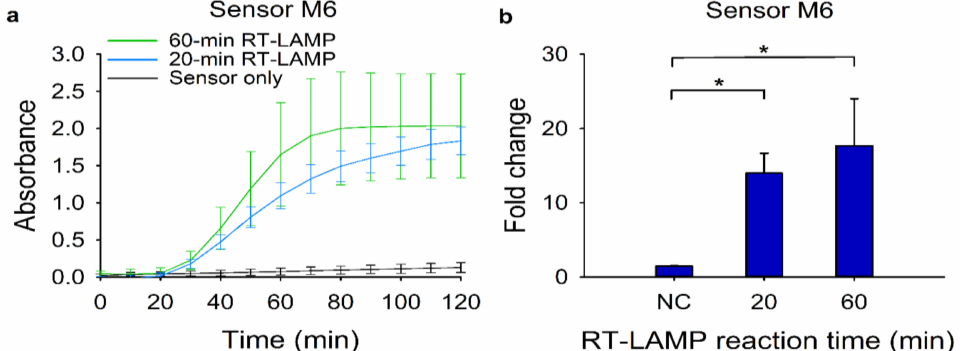
Figure 5. Reduction of the overall reaction time for the modified RT-LAMP and the subsequent toehold reaction. For the reduction of overall reaction time, 120 copies of target RNA for sensor M6 were used. ( a ) Absorbance (570 nm) changes of the toehold reaction with or without trigger RNA using sensor M6. Blue and green lines indicate the toehold reaction after 20-min and 60-min RT-LAMP reactions, respectively, in the presence of target RNA. The black line denotes the same reaction for 60 min in the absence of target RNA. ( b ) Fold change was calculated as the absorbance values from toehold reaction with trigger RNA divided by that without the trigger RNA at 40 min. For the negative control (NC), the RT-LAMP reaction product with no target RNA was used. Two-tailed student’s test; * p < 0.05; Error bars represent ± s.d., n =